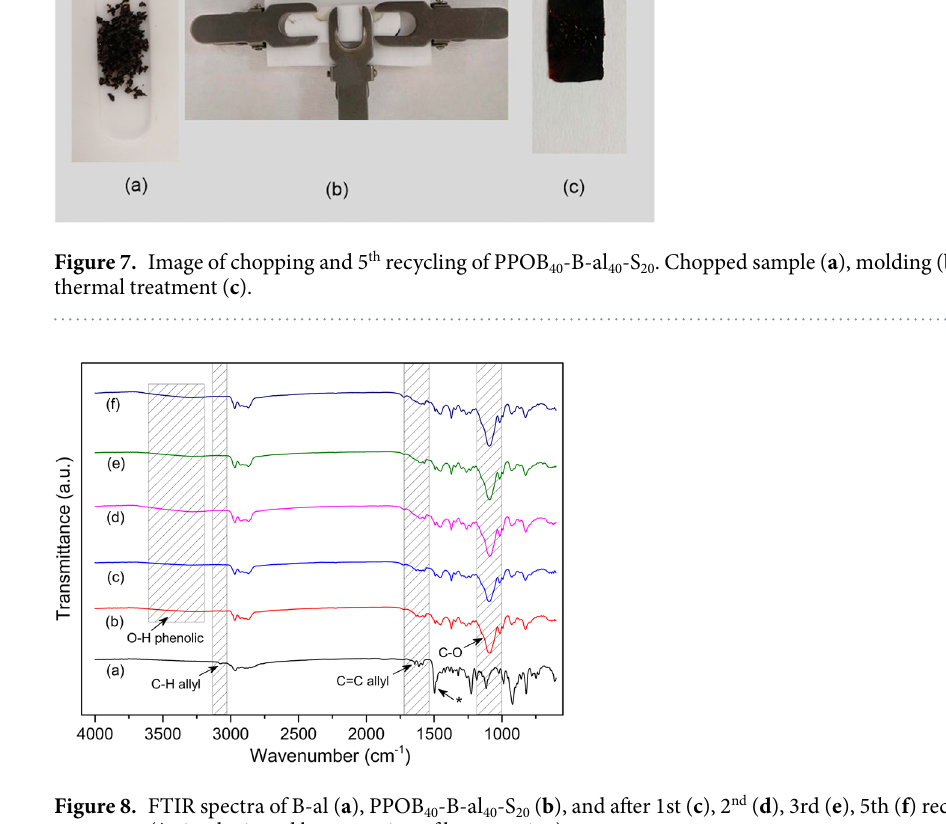
Figure 8. FTIR spectra of B-al ( a ), PPOB 40 -B-al 40 -S 20 ( b ), and after 1st ( c ), 2 nd ( d ), 3rd ( e ), 5th ( f ) recycling processes. ( * tri-substituted benzene ring of